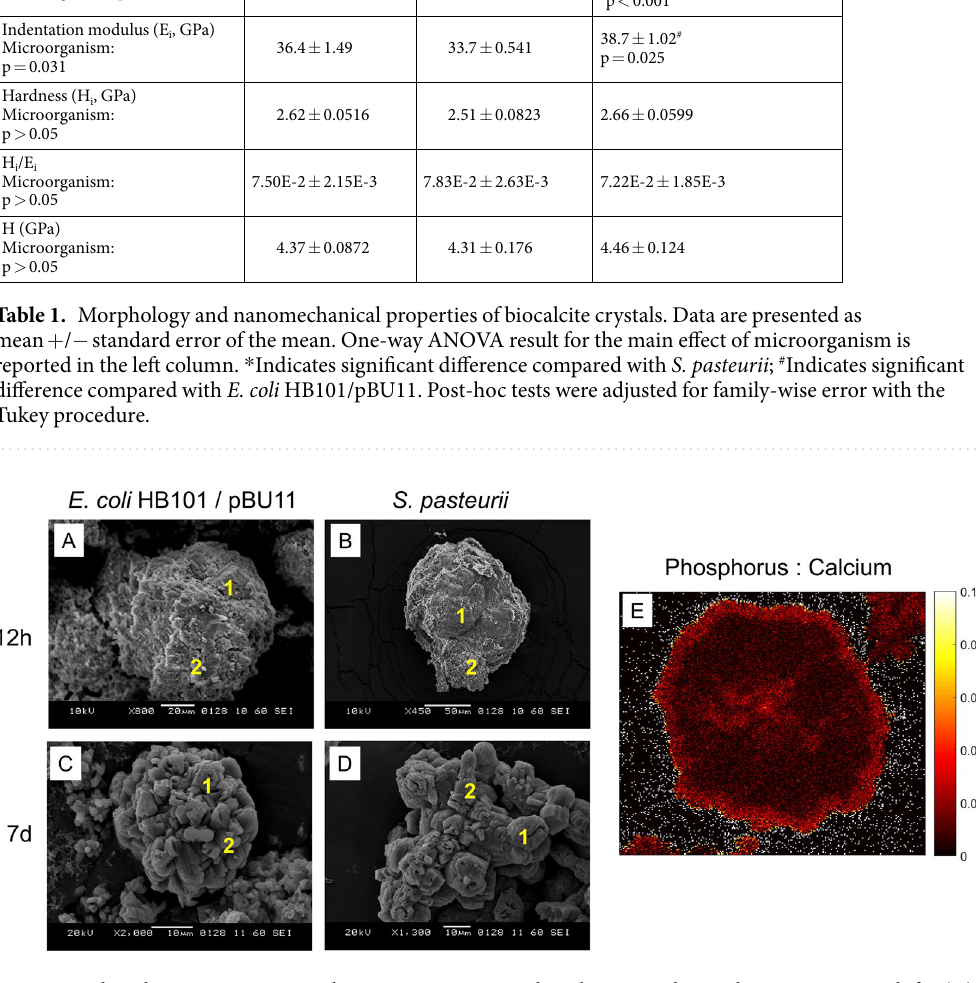
Figure 4. Phosphorus participates in biogenic CaCO 3 crystal nucleation and growth. SEM-EDS at 12h for ( A ) E. coli HB101/pBU11 and ( B ) S. pasteurii show well-defined, casted regions of CaCO 3 (1) adjacent to poorly organized CaP (2) on the same structure. By 7d, ( C ) E. coli HB101/pBU11 and ( D ) S. pasteurii both show only